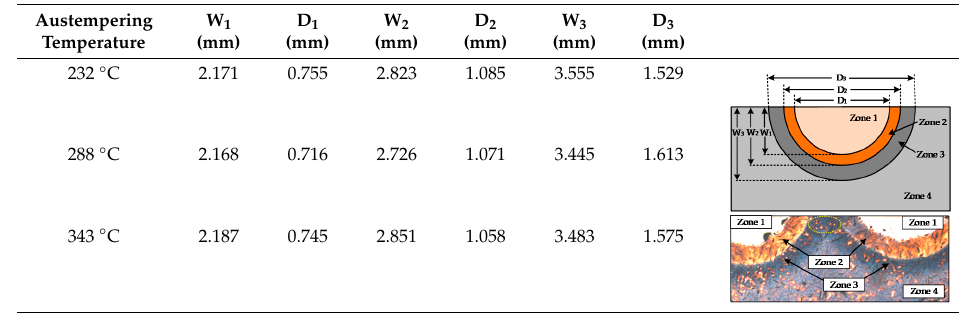
Table 5. Width and Depth of Laser-Hardened and Heat-Affected Zones for LHQTGI Specimens with Various Tempering Temperatures.